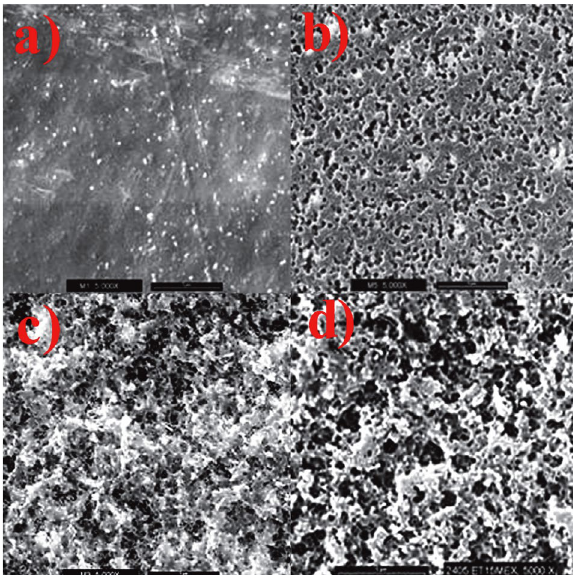
Figure 4. ABS SEM micrographs of (a) untreated; (B) and (c) etch- ing with the sulfuric-chromic acid bath (350g/L), T avg = 75 °C, t inm = 4 and 10 min of undyed parts, respectively; (D) 350 g / L, T avg = 75 °C, 15 min t inm = white ABS samples. The scale bars in all cases were 1 µm at 5000X.